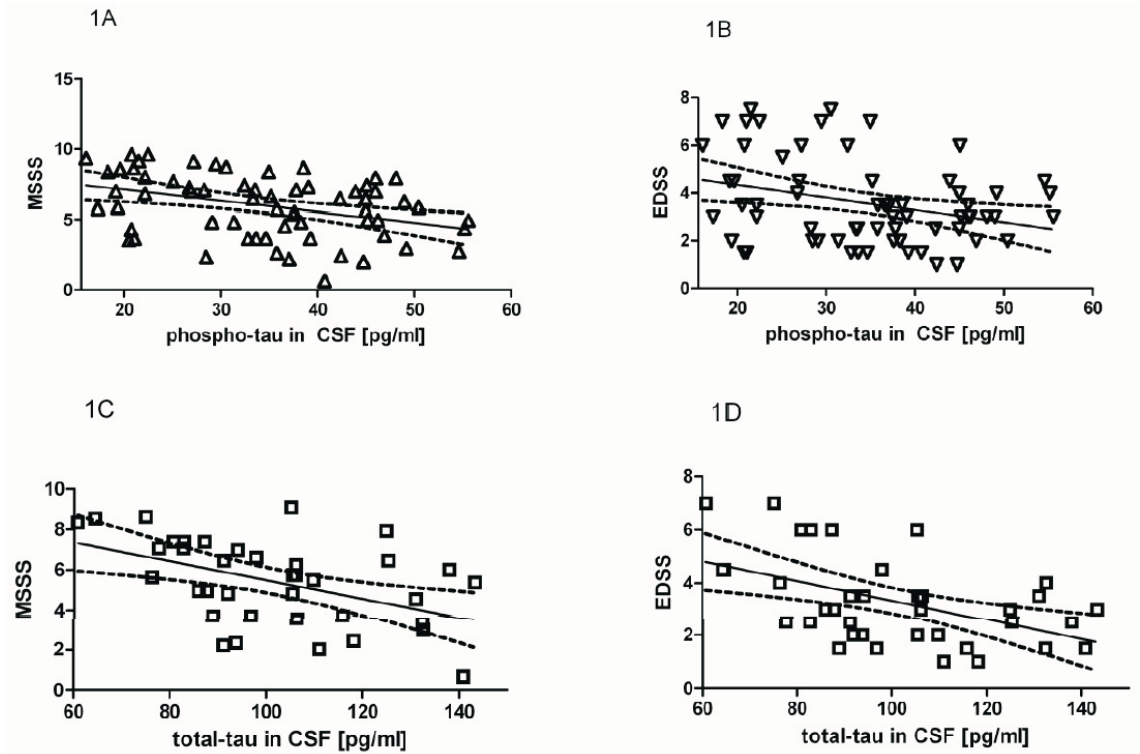
Figure 1. Linear regression line with 95% CI band for CSF tau and EDSS and MSSS. Minimal values on x axis are defined as detection threshold for phospho-tau (i.e. 15.6 pg/ml) and total-tau (i.e. 60.0